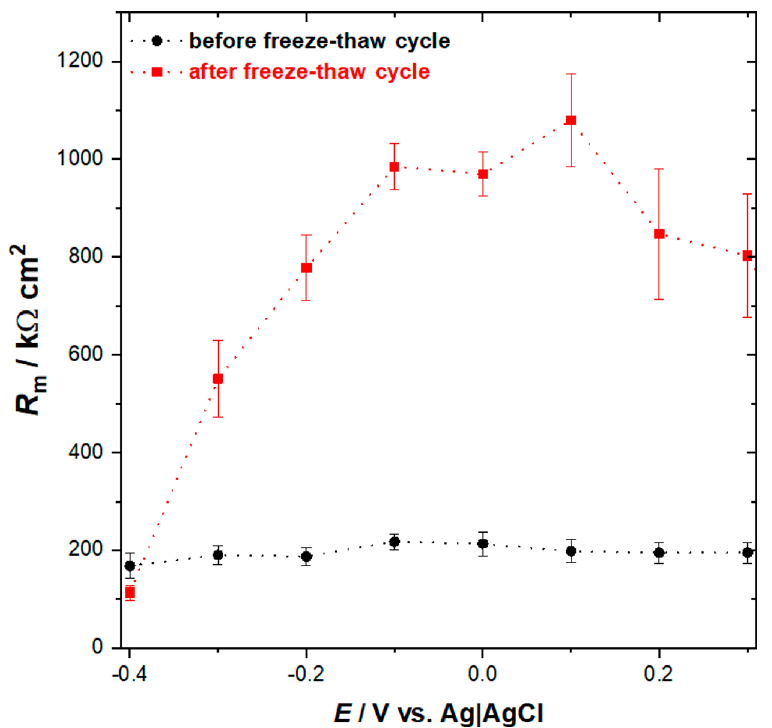
Figure 6. Changes of the membrane resistance ( R m ) as a function of the potential applied to the thioglucose-modified Au(111) electrode with lipid assembly before (black) and after (red) one freeze–thaw cycle.